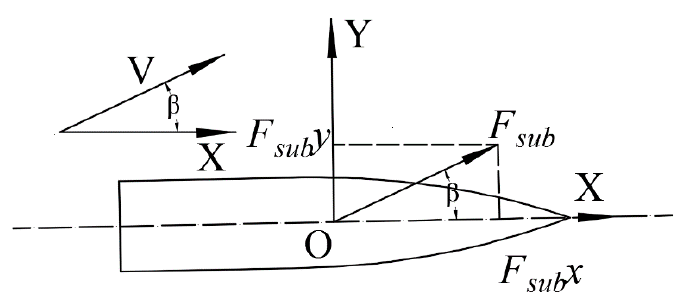
Figure 4. A schematic diagram of submersion forces. F sub is the submersion force, F subx is the component of the submersion force on the X-axis, F suby is the component of the submersion force on the Y-axis, V is the ship speed, v x is the X component of the velocity, and v y is the Y component of the velocity.